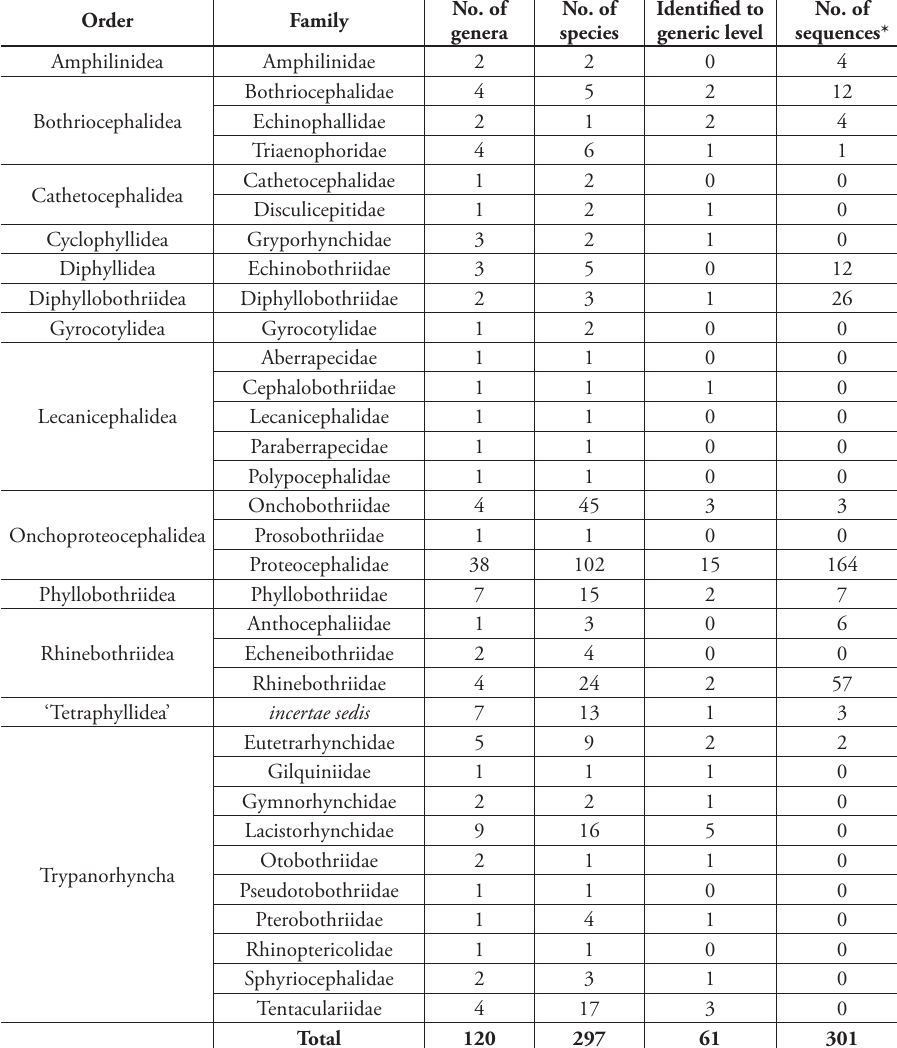
Table 1. Survey of fish cestodes from South America according to their high taxonomic level classification.